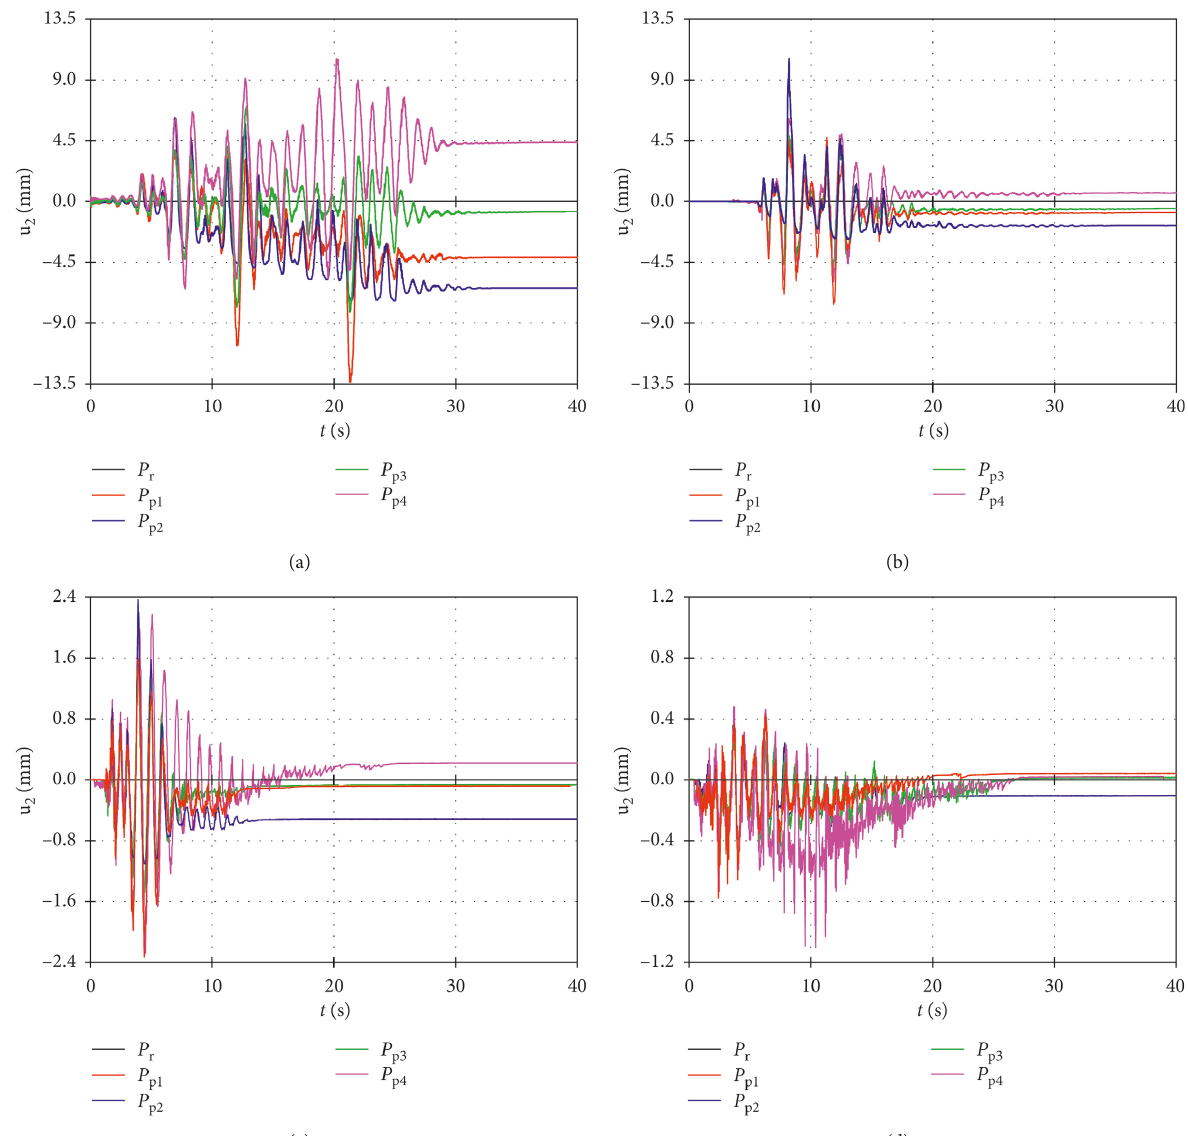
Figure 18: Horizontal displacement at the foundation top ( u (c) Accelerogram Ston (AS). (d) Accelerogram B. Luka